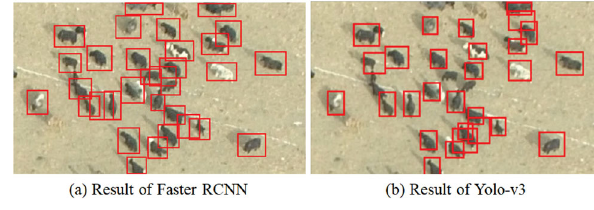
Fig. 7 Example results from Fast RCNN and Yolo-v3.